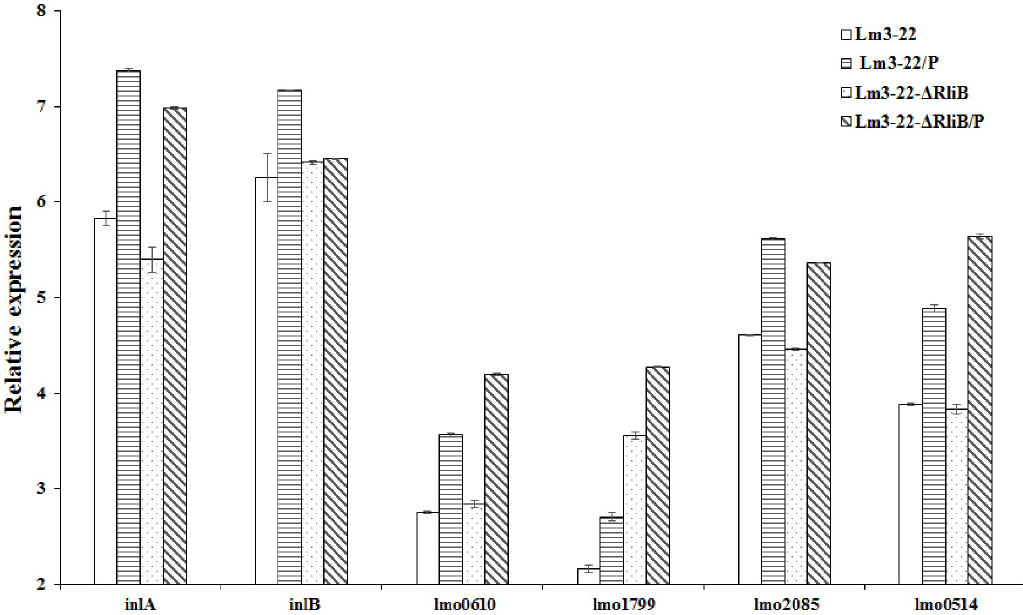
Fig 5. The relative expression levels of six surface protein coding genes in L . monocytogenes . Lm3-22 and Lm3-22- Δ rliB without phage were the control group. Experiment groups had phage added and were incubated at 37˚C for 120 min. Data was analyzed using LightCycler 1 96 SW 1.1 software. Mean fold-change values of triplicate independent experiments and standard deviation are shown.